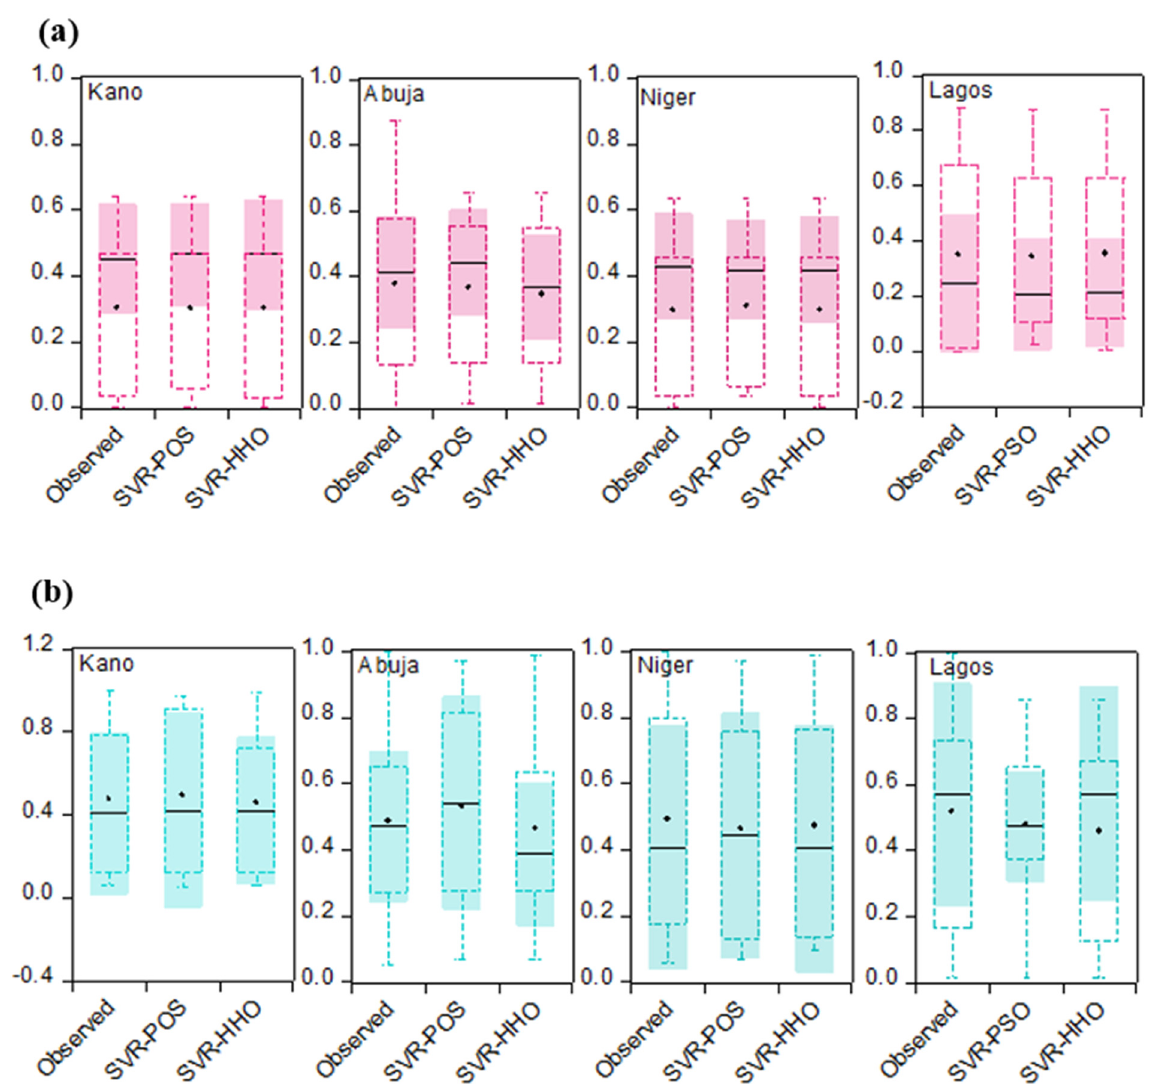
Figure 9. Boxplot for SVR-PSO and SVR-HHO models during ( a ) calibration and ( b ) verification phases.